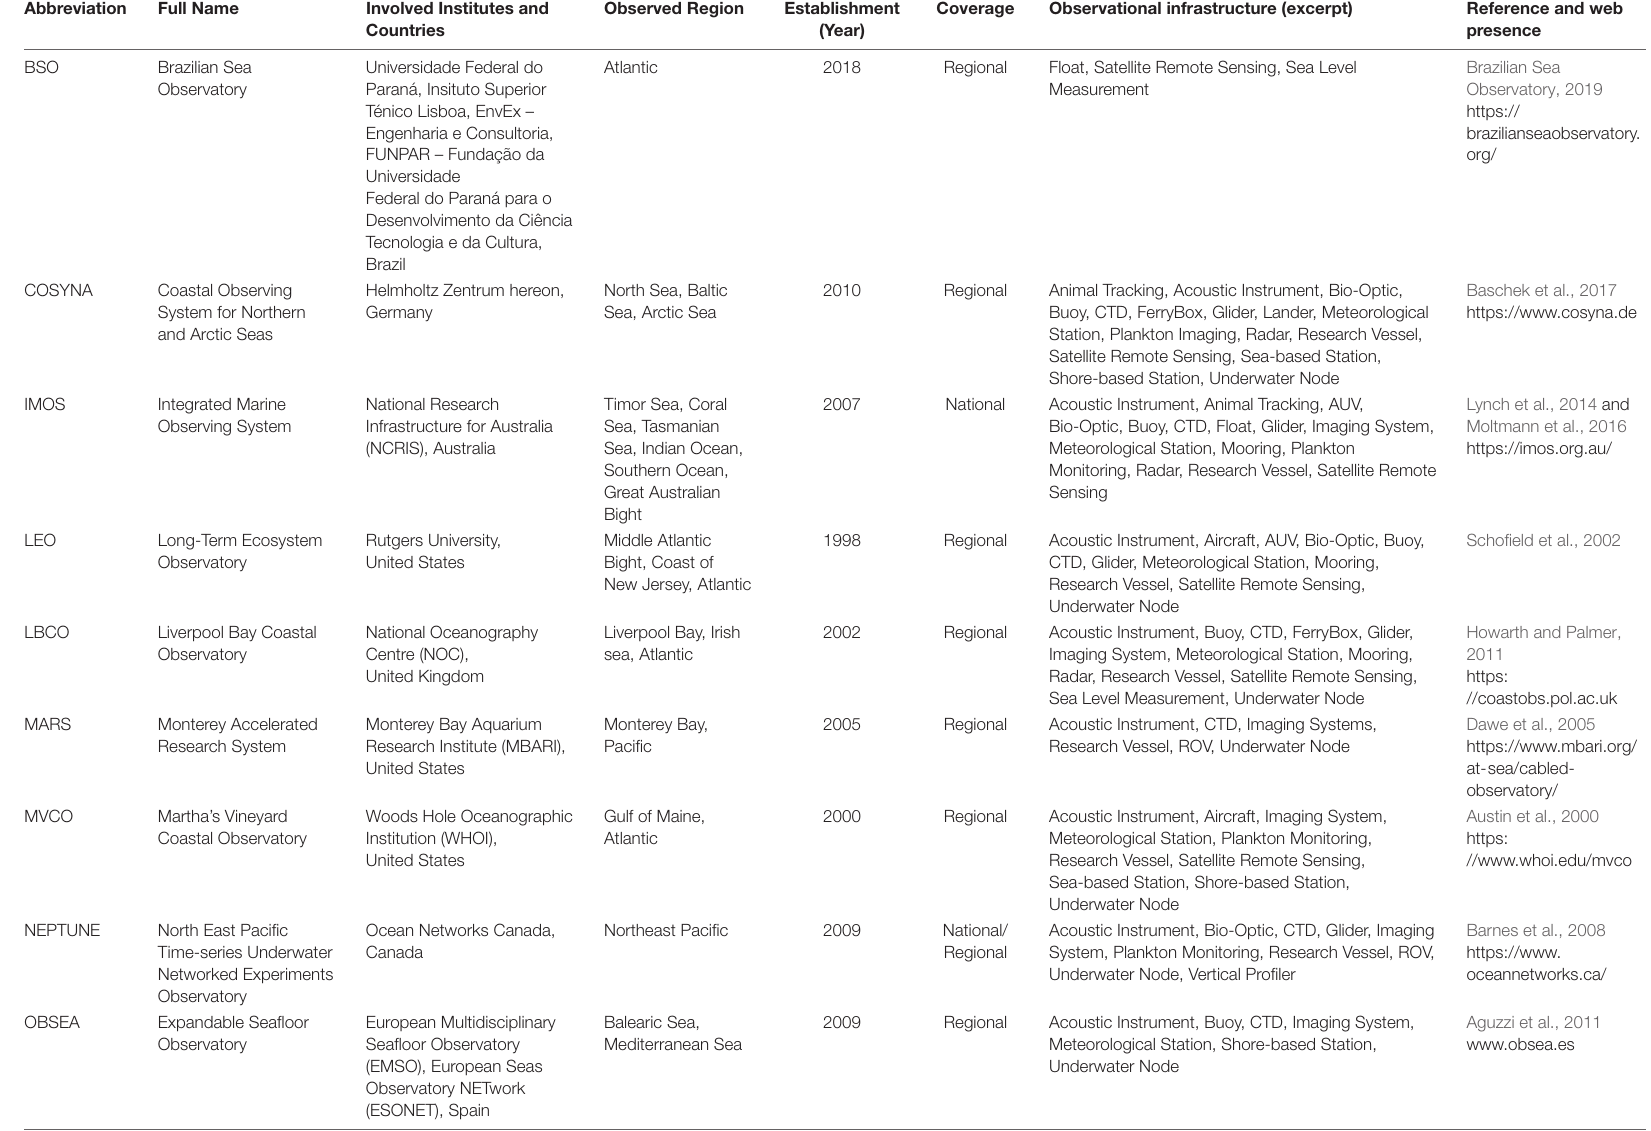
TABLE 1 | Selection of coastal observatories and collaborating observational sites in alphabetical